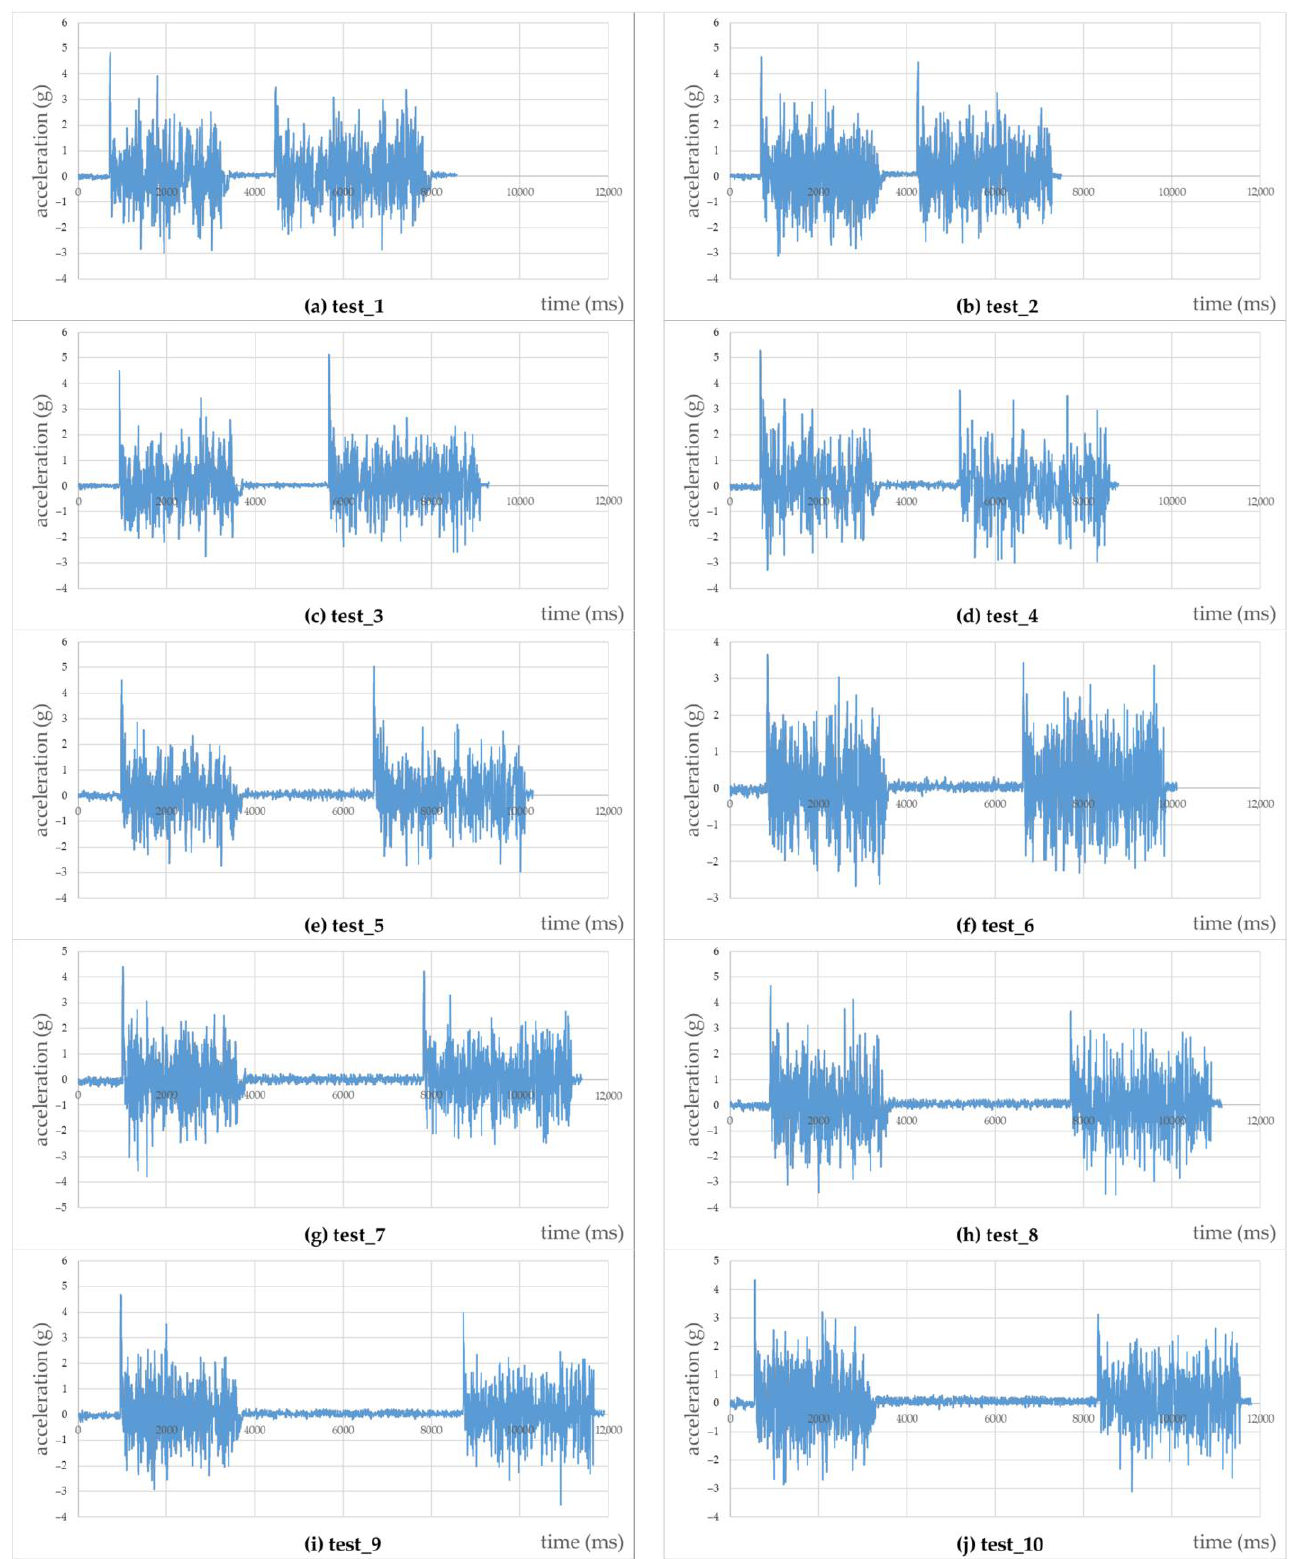
Figure 4. Raw acceleration data from the IIoT device. A stop signal was sent from the digital layer to the physical layer at intervals of 1000–5000 milliseconds (from ( a – j ); each pair, e.g., ( a , b ) means different tests but under the same circumstances, i.e., ( a , b ) 1000 ms, ( c , d ) 2000 ms, ( e , f ) 3000 ms, ( g , h ) 4000 ms, and ( i , j ) 5000 ms).